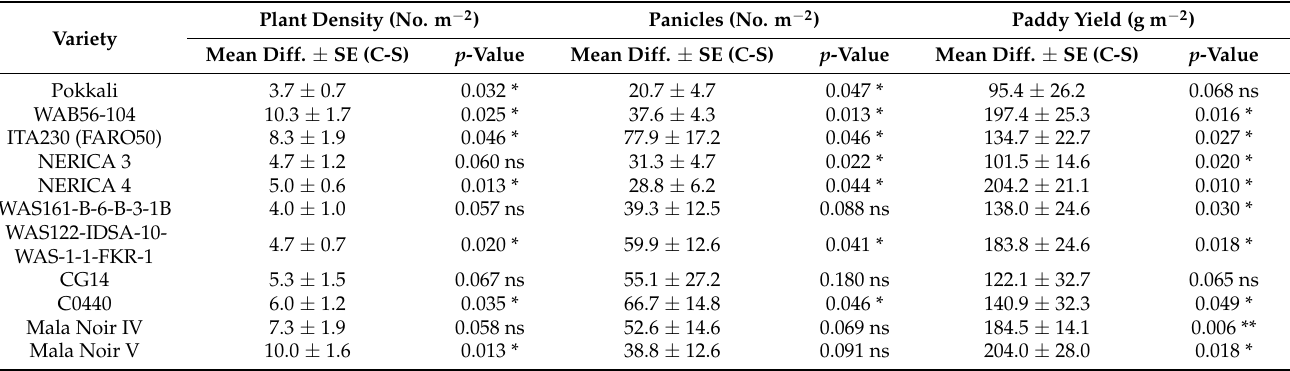
Table 3. Pairwise comparison of rice-genotype yield characters between the control (C) and saline (S) wetlands (Exp.